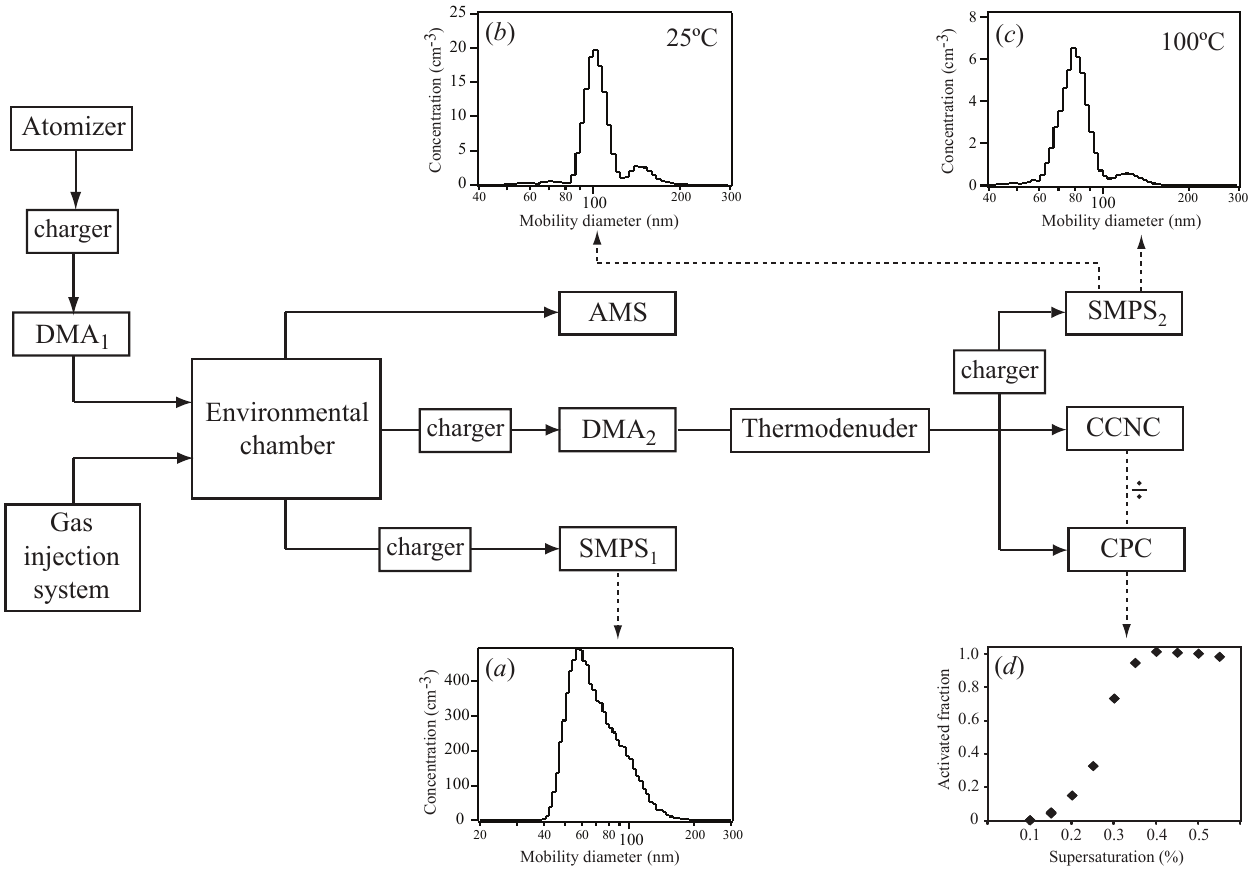
Fig. 1. Schematic diagram of the experimental setup for the study of CCN activity of the secondary organic material produced by the photooxidation of isoprene. Panels show examples of collected data: (a) A number-diameter distribution of particles exiting the chamber. (b) A number-diameter distribution of particles after selection by DMA 2 and passage through the thermodenuder at 25 ◦ C (cf. further examples in Fig. 2). (c) A number-diameter distribution after passage through the thermodenuder at 100 ◦ C. (d) A CCN activation curve. Legend: AMS, aerosol mass spectrometer; CCNC, cloud condensation nucleus counter; CPC, condensation particle counter; DMA, differential mobility analyzer; and SMPS, scanning mobility particle